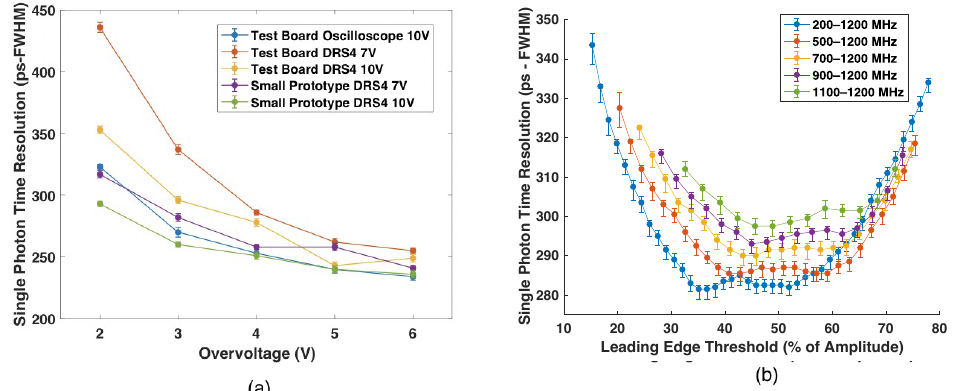
Figure 7. Measured single photon time resolution for Hamamatsu S13360-6075 SiPMs with readout instrumented in both a test board and also in a small scale prototype readout is shown in ( a ). The SPTR, plotted as a function of different digital bandpass filters is also shown in ( b